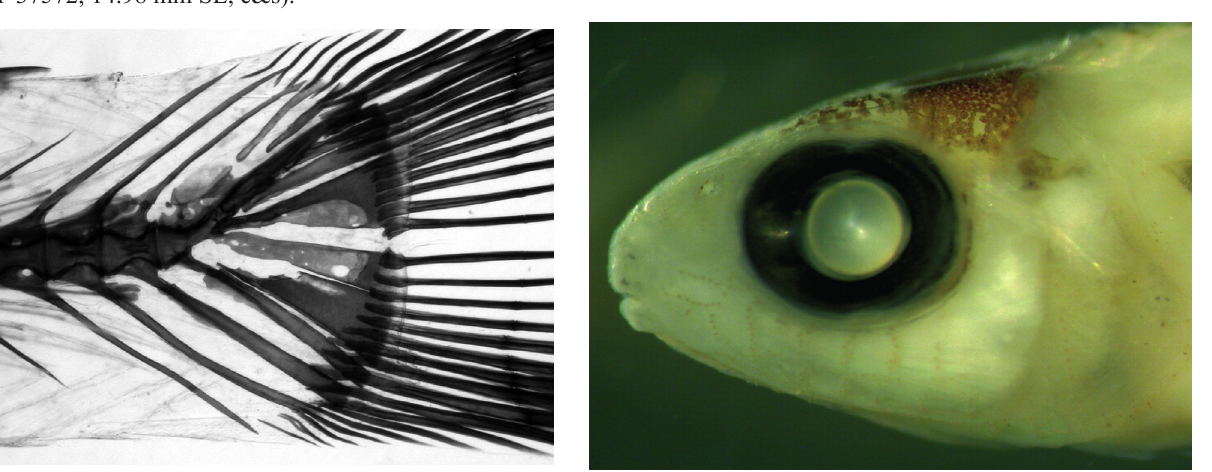
Fig. 4. Lateral view (left side) of the head of the holotype of Amazonspinther dalmata showing the pattern of neuromasts distribution (MCP 38623, 19.63 mm